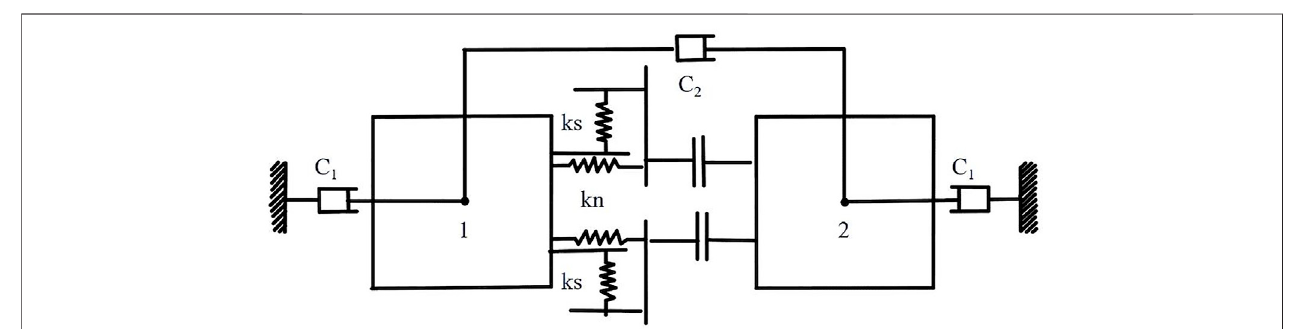
FIGURE 4 | Schematic of the contact surface normal and tangential